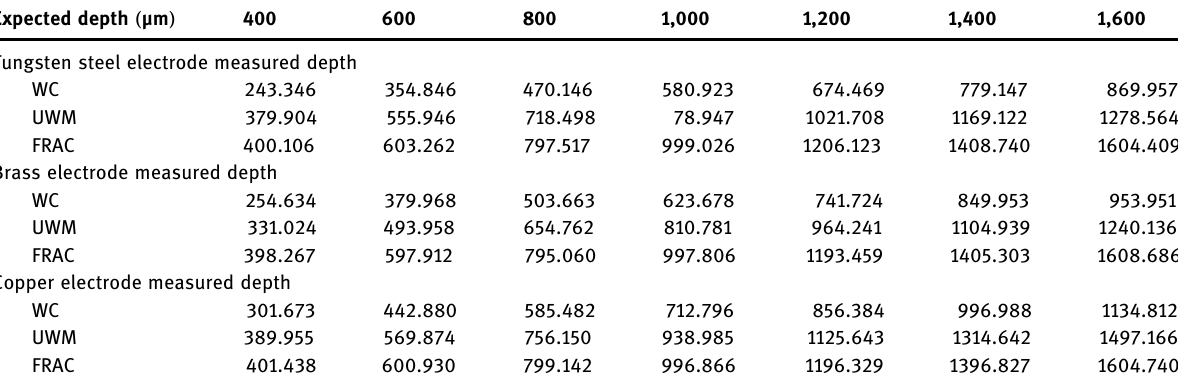
Table 4: The measured depth of blind holes